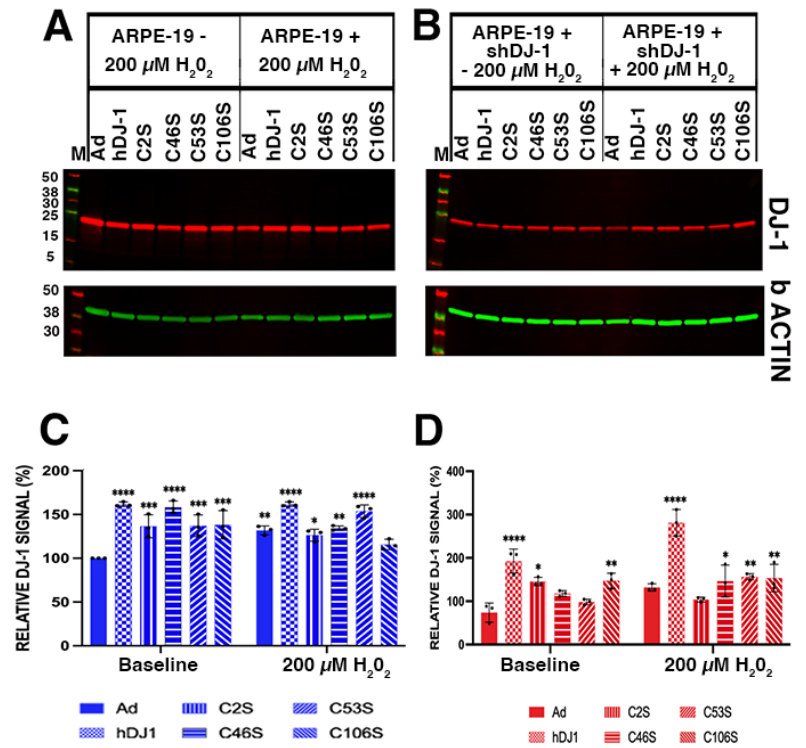
Figure 3. Under oxidative stress conditions, ARPE-19 monolayers transduced with the several DJ-1 constructs displayed significantly higher immunoreactivity for DJ-1. ( A , B ) Representative Western blot of RPE monolayers reacted with DJ-1 and b actin; ( A ) ARPE-19 (blue bars); ( B ) ARPE-19 + shDJ-1 (red bars). ( C , D ) Total levels of DJ-1 protein in the RPE lysates. ( C ) ARPE-19; ( D ) ARPE-19 + shDJ-1. Data are expressed as mean ± SD; levels were normalized to ARPE-19 + Ad. * p = 0.01 to 0.05; ** p = 0.001 to 0.01; *** p = 0.0001 to 0.001; **** p < 0.0001; two-way ANOVA; n = 3. Dots in ( C , D ) = individual experiments; asterisks above for significance.